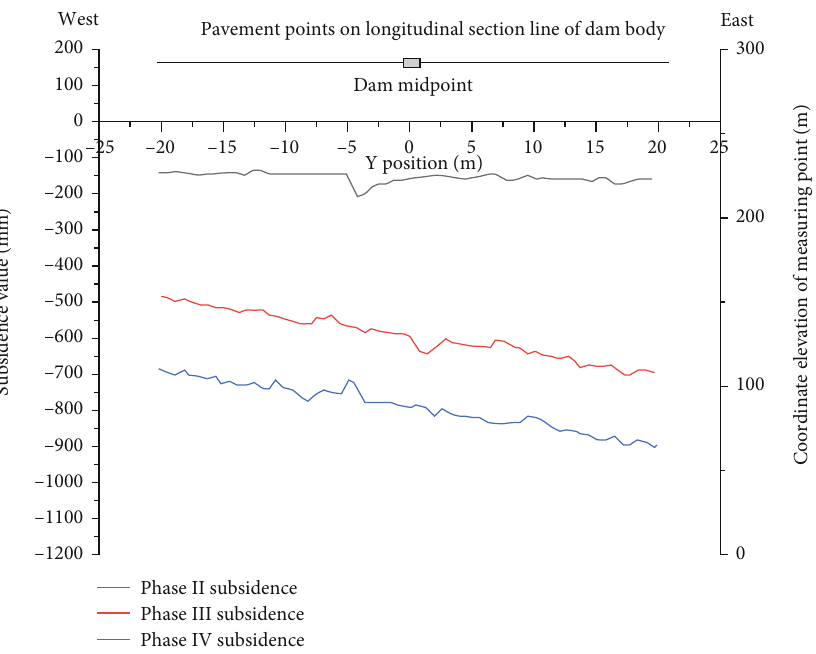
Figure 14: The subsidence deformation of the longitudinal section line of the